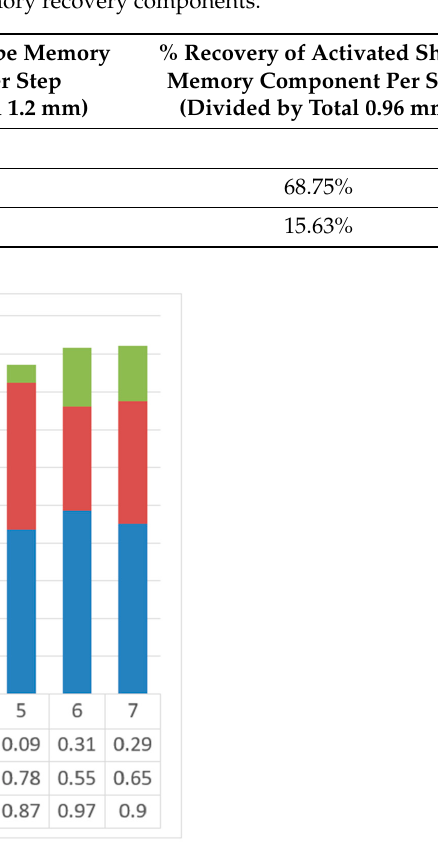
Table 3. Numerical values and percentages of shape memory recovery components.